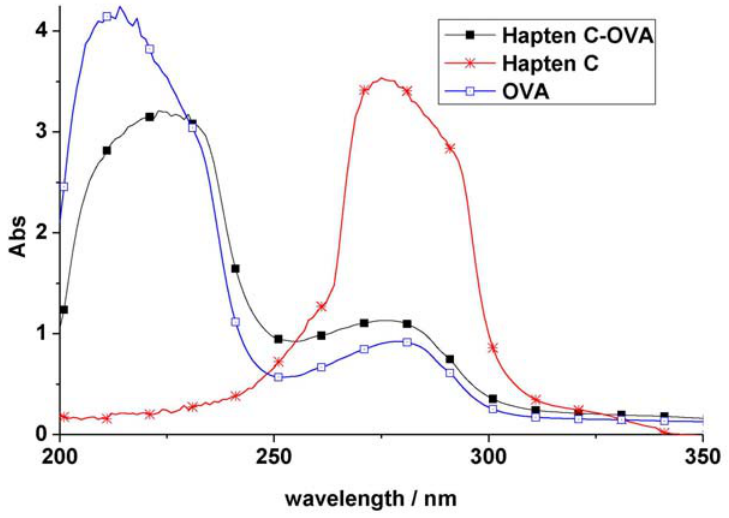
Figure 3. Verification of conjugation for typical hapten-protein